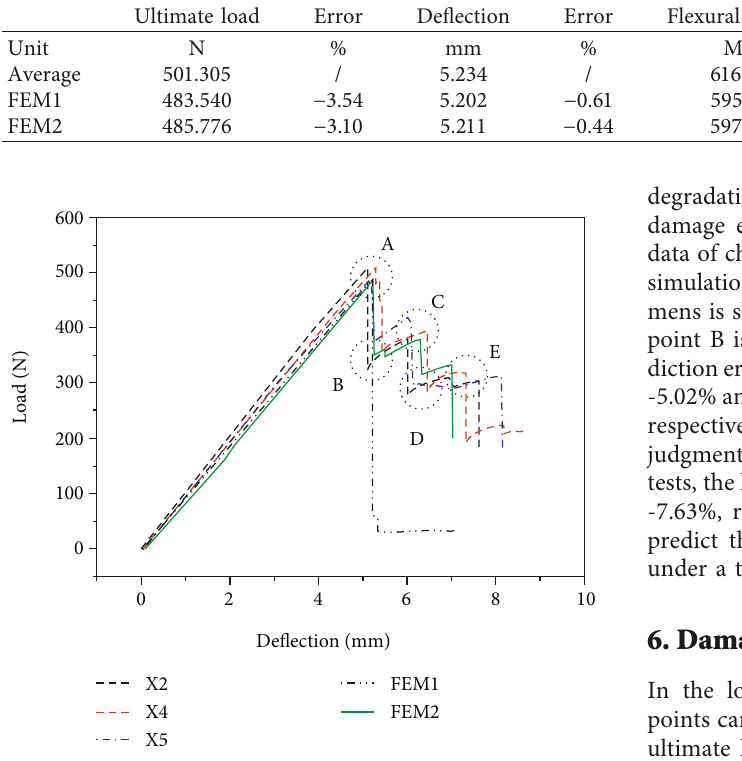
Figure 4: Comparison of the load-deflection curves of the nu- merical model and